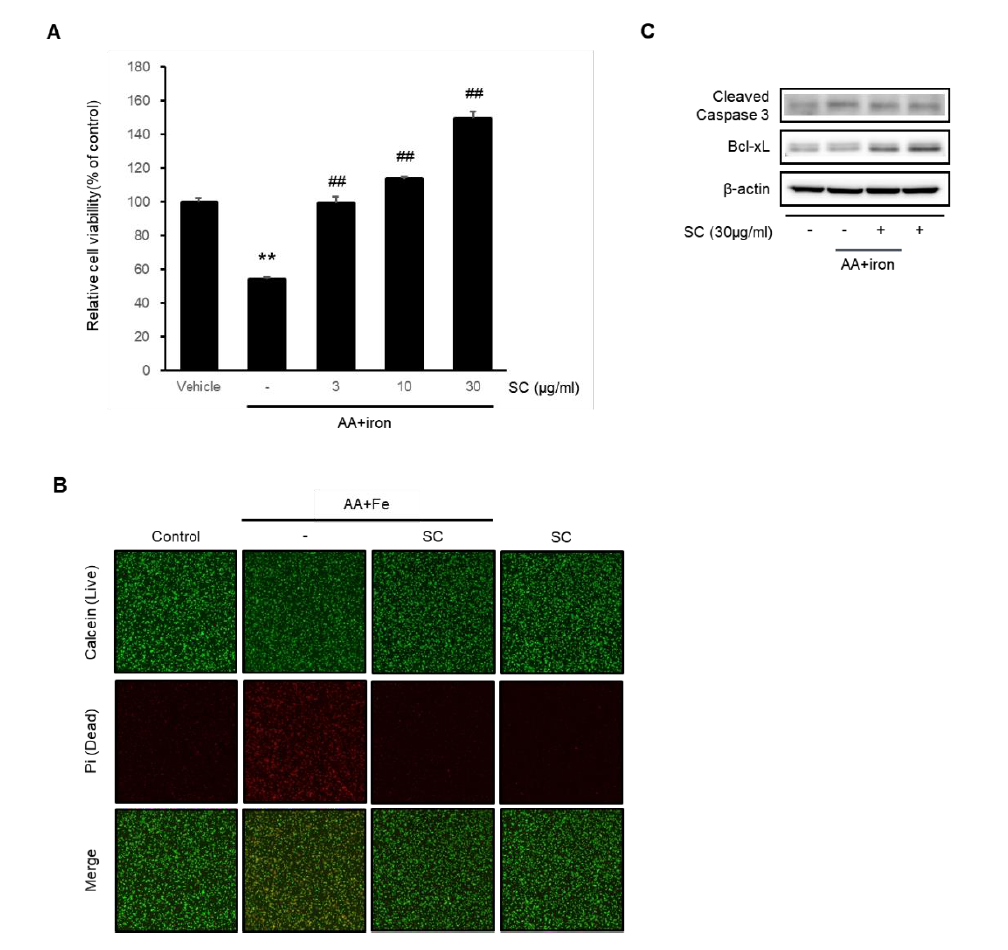
Figure 1. Protective effect of SC on cytotoxicity caused by AA + iron. ( A ) Cell viability was assessed by an MTT assay. HepG2 cells were treated with SC (3, 10, and 30 µ g/mL) for 1 h and incubated with 10 µ M AA for 12 h, followed by incubation with 5 µ M iron for 6 h. The data represent the mean ± SD of three replicates (** p < 0.01 between control and AA + iron-treated cells; ## p < 0.01 between AA + iron and AA + iron-treated cells with SC). ( B ) The cell viability was measured using calcein AM and propidium iodide (Pi) staining. HepG2 cells were incubated with AA + iron as ( A ), with or without SC 30 µ g/mL, and then stained with calcein AM (0.5 µ g/mL) and Pi (0.5 µ g/mL). Calcein and Pi fluorescence was detected using a fluorescent microscope ( × 100); ( C ) immunoblotting analysis for apoptosis-related proteins was performed with HepG2 cell lysates. HepG2 cells were stimulated by AA with or without SC 30 µ g/mL, and then the iron for 1